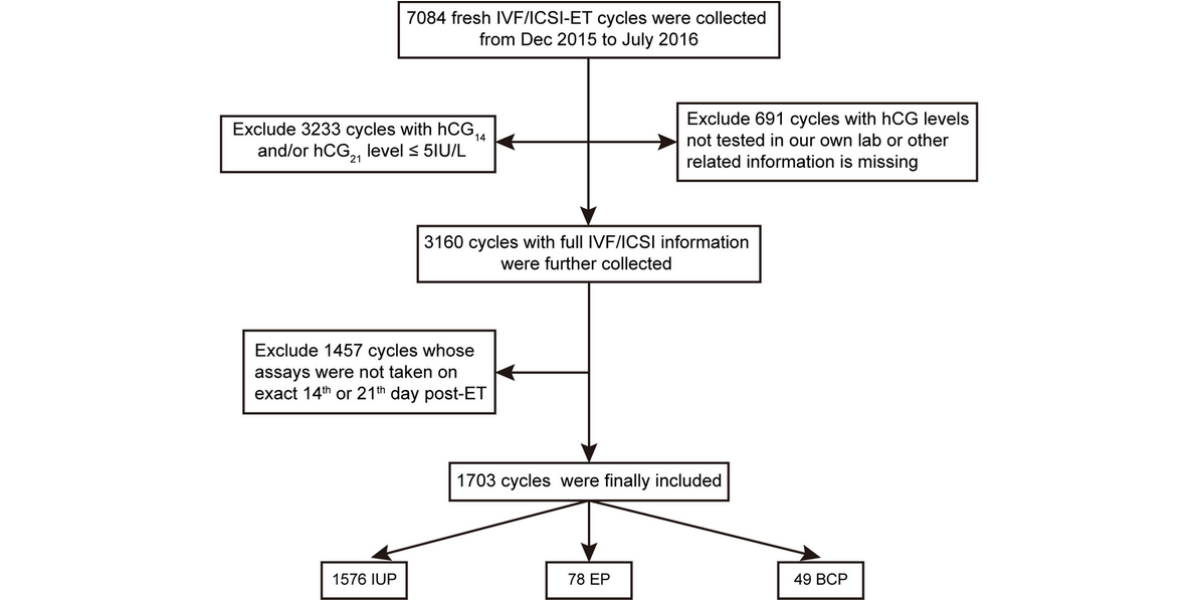
Figure 1. Flowchart of the data selection strategy. hCG14 and hCG21: serum hCG levels on days 14 and 21 post–embryo transfer; EP: ectopic pregnancy; ET: embryo transfer; IUP: intrauterine pregnancy; BCP: biochemical